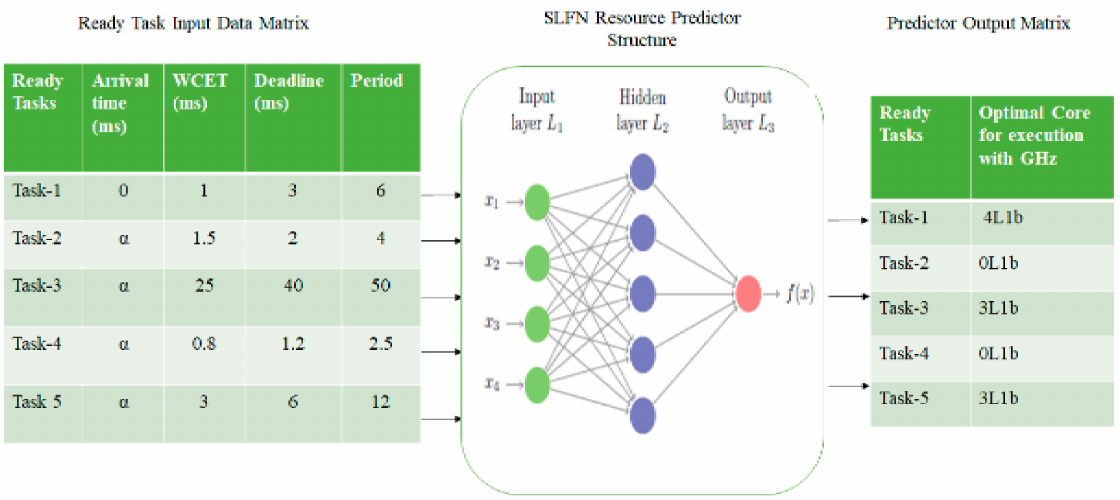
Figure 5. SLFN Resource Predictor Results for periodic task graph mapped on hardware configuration-1 (Odroid